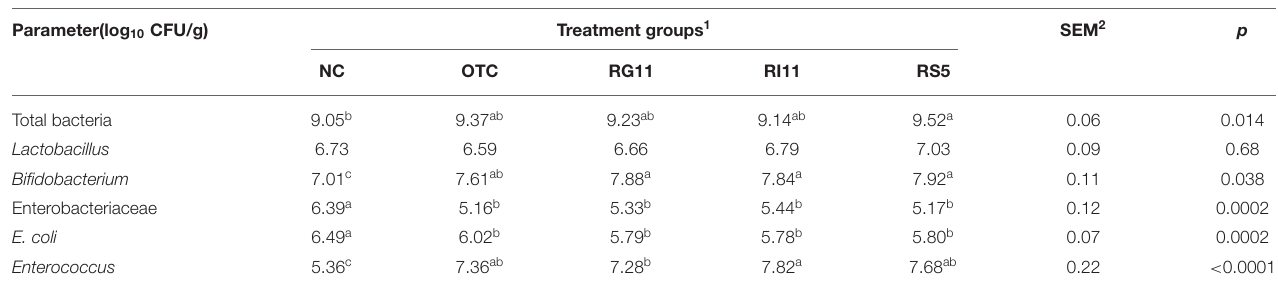
TABLE 12 | Ceca microbial quantification of chickens when fed with different postbiotic. Parameter(log 10